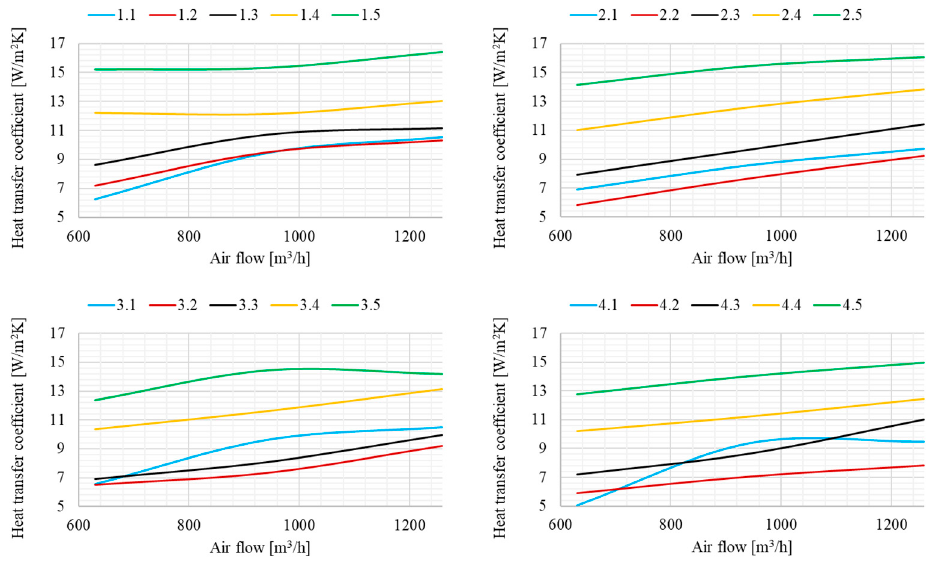
Figure 13. Heat transfer coefficient variation with air flow obtained from CFD simulations.